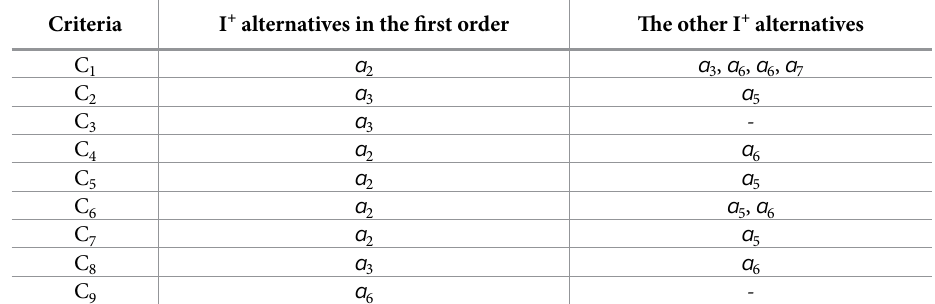
Table 3. Positive ideal solutions